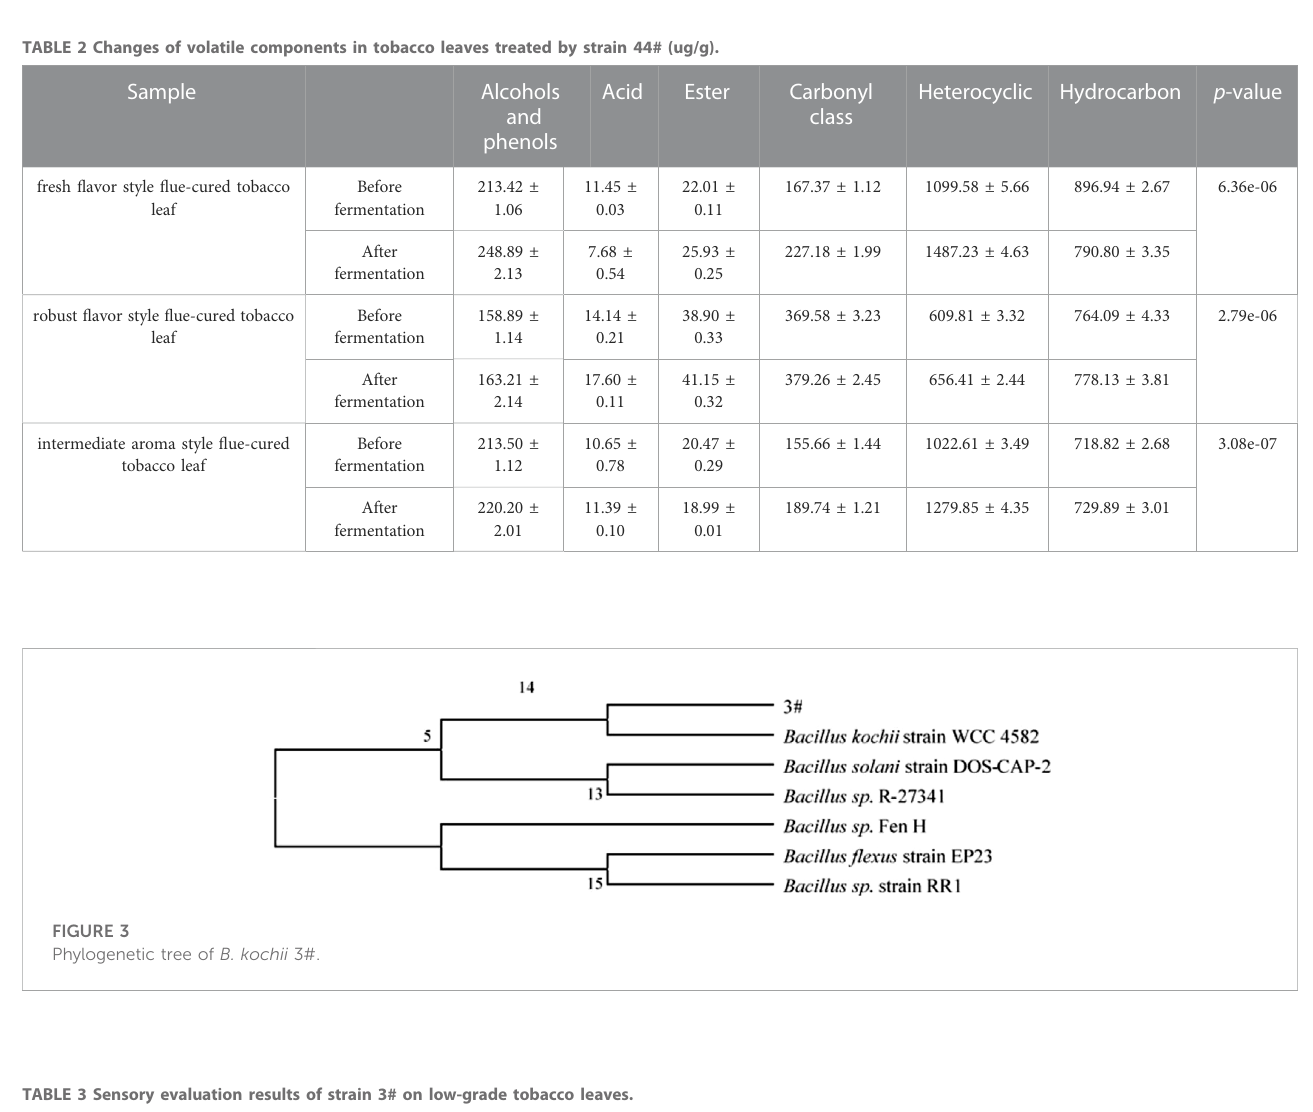
TABLE 3 Sensory evaluation results of strain 3# on low-grade tobacco leaves.